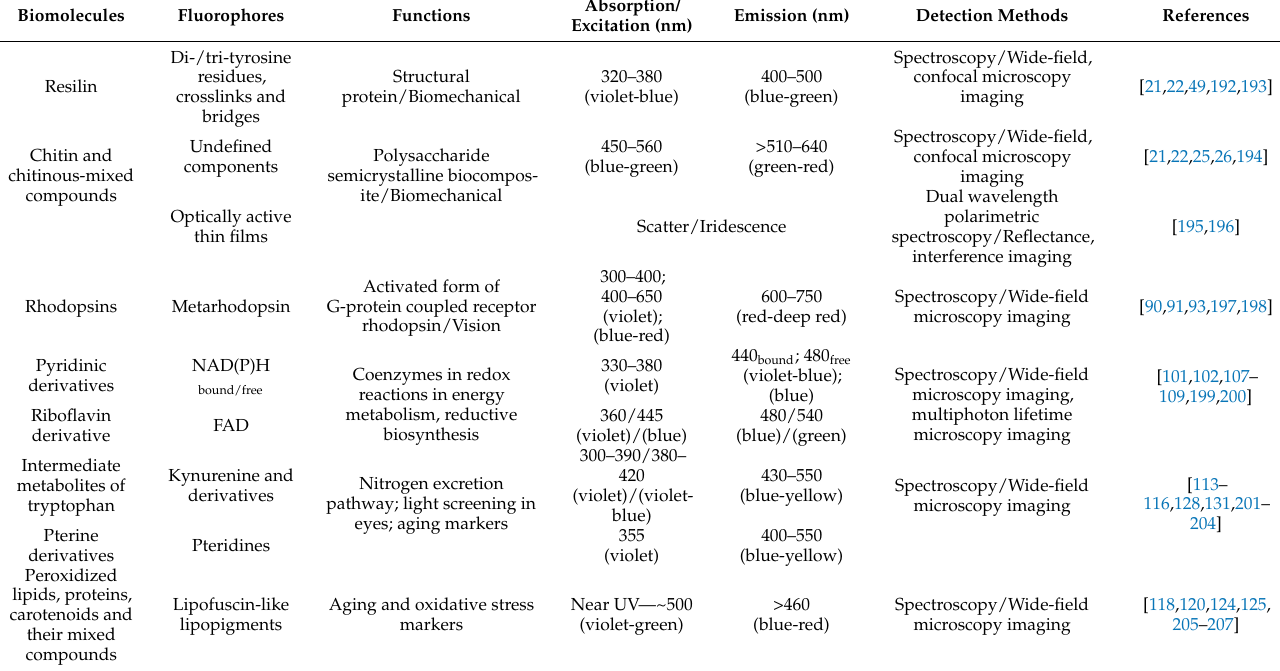
Table 1. Fluorescing compounds in